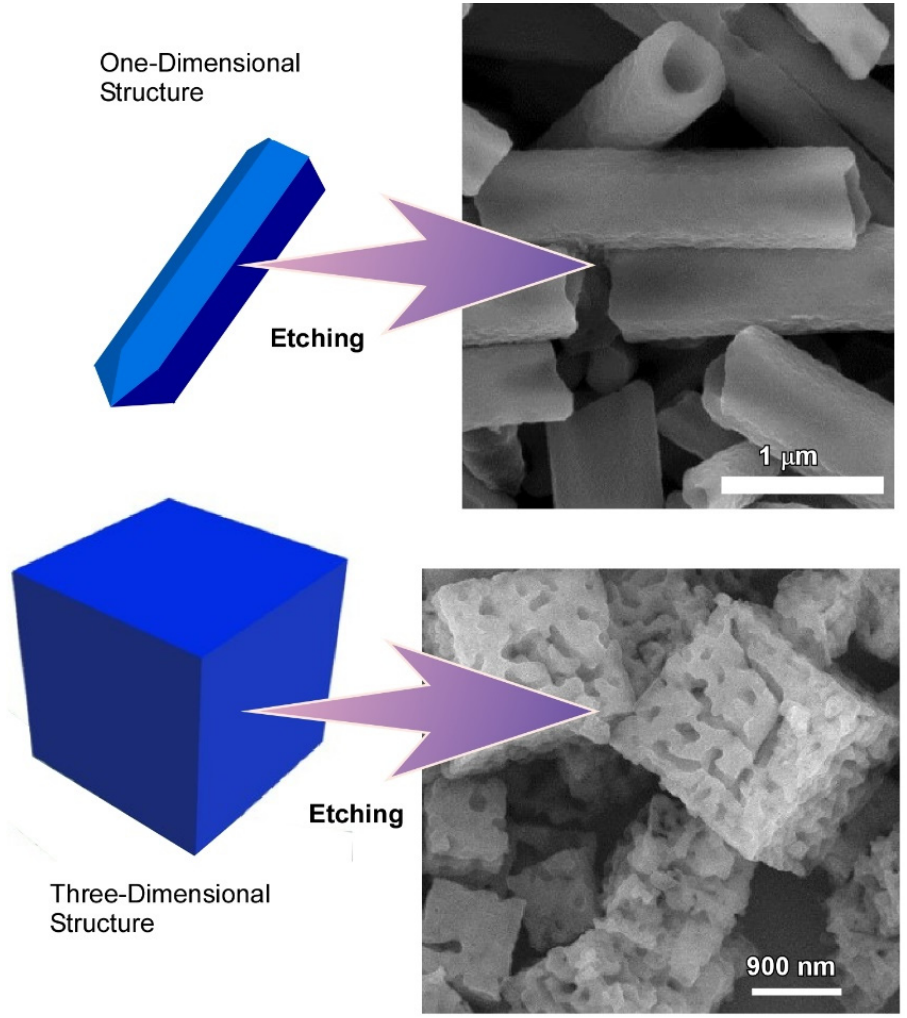
Figure 4. Formation of hollow and hierarchical fullerene nanostructures via face-selective etching of self-assembled fullerene crystals. Reprinted with permission from Reference [137]. Copyright 2020 Royal Society of Chemistry.